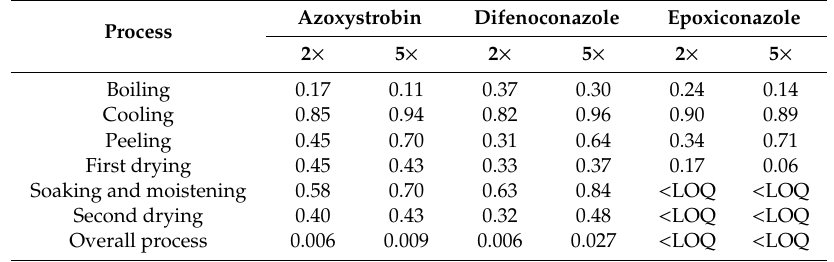
Table 4. Processing factors (PFs) for the three pesticides after different processes ( n = 3).